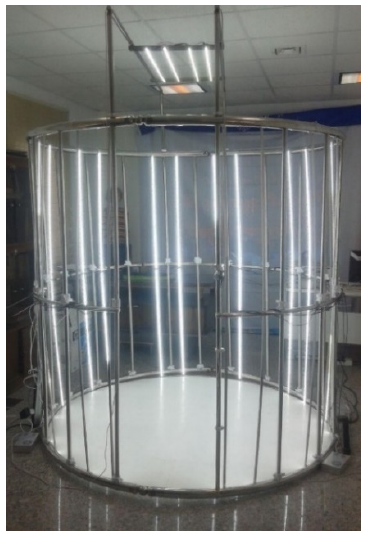
Figure 3. Lighting in the 3D scanning system.